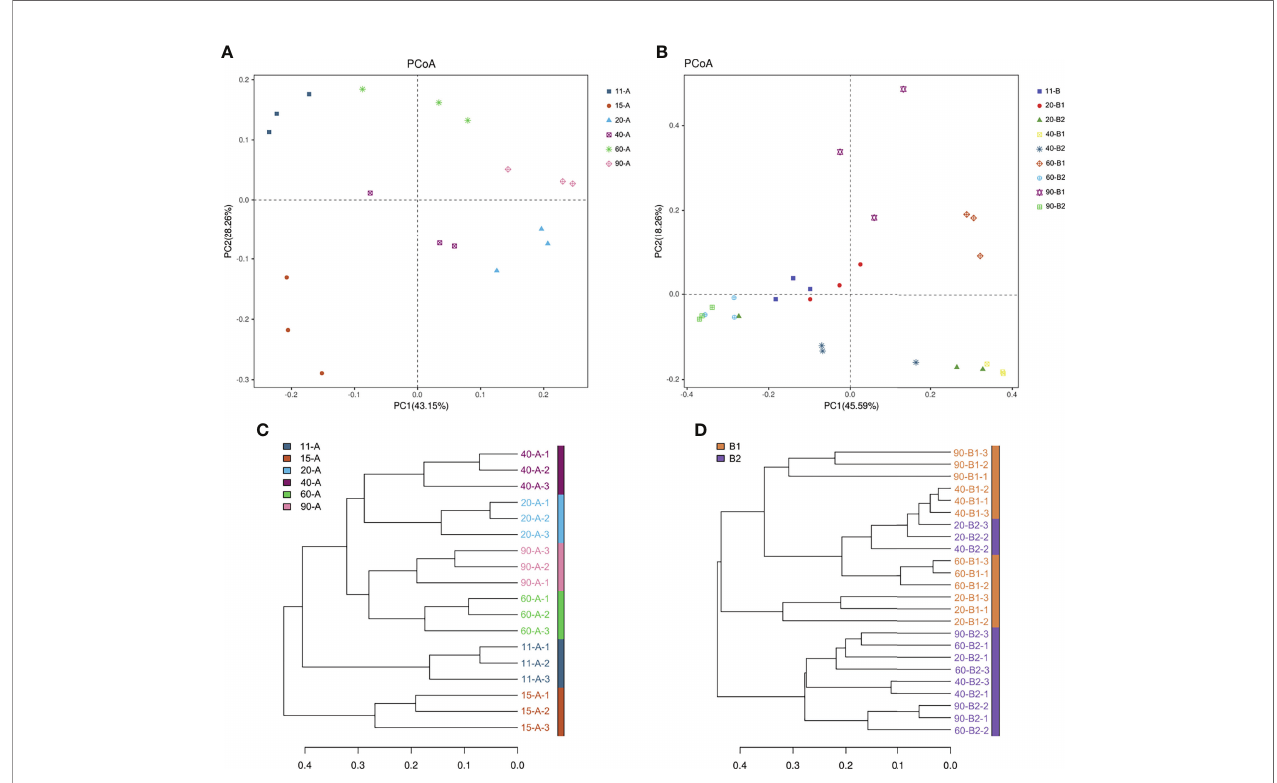
FIGURE 4 | Beta diversity measures at the OTU level. (A) PCoA plot using beta-weighted UniFrac of Experiment I. (B) PCoA plot using beta-weighted UniFrac of Experiment II. (C) Clustering of intestinal samples from Experiment I according to the weighted UniFrac distance metric. (D) Clustering of intestinal samples from Experiment II according to the weighted UniFrac distance